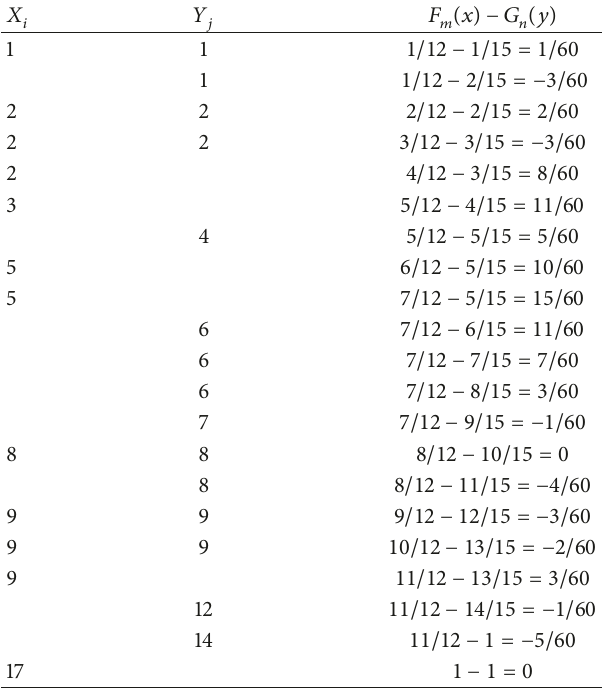
Table 3: The results of Smirnov